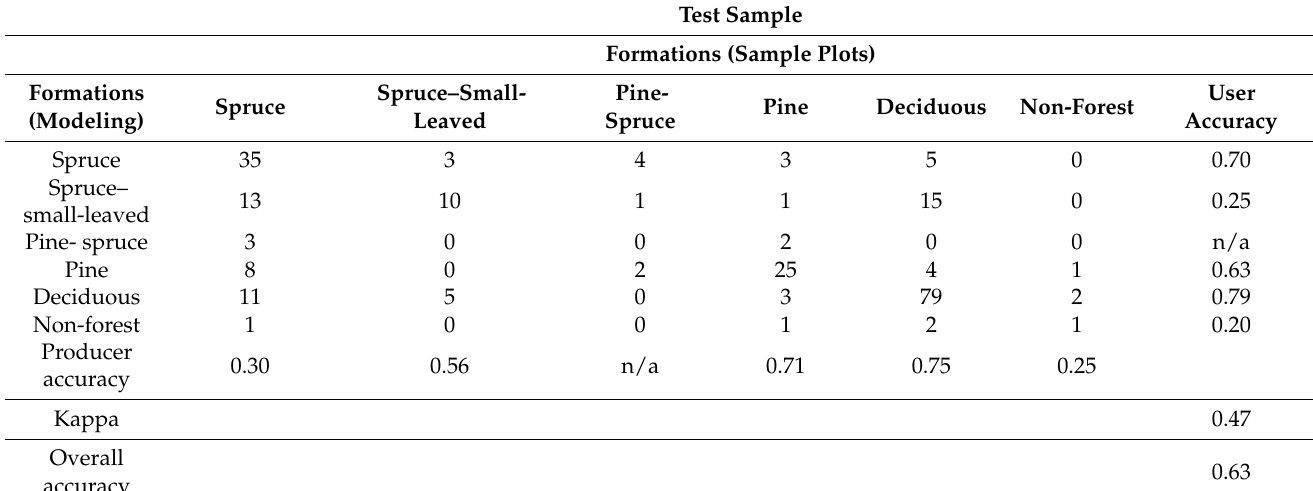
Table 3. Confusion matrix test sample (random